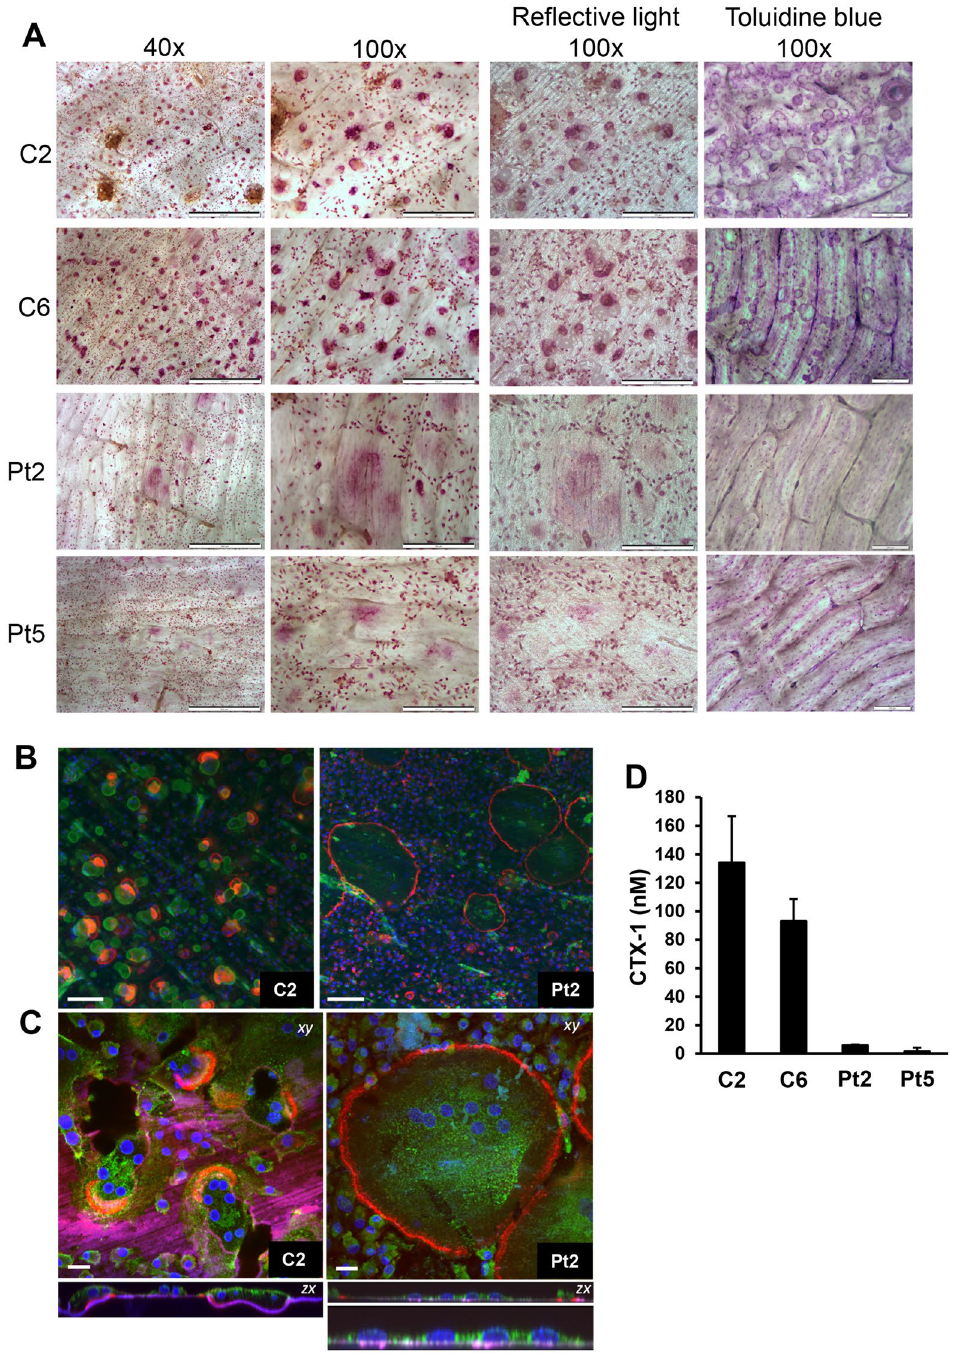
Figure 4. Patient-derived osteoclasts form actin rings but are unable to resorb bone. ( A ) TRAP staining of CD14 + cells cultured in M/RL on bone for eight days. Scale bar 40 × panel: 500 μ m, scale bar 100 × light microscope and reflective light panel: 200 μ m, scale bar 100 × toluidine blue panel: 100 μ m. ( B , C ) Osteoclasts were analyzed by confocal microscopy; ( B ) stained with TRITC-phalloidin (red), DAPI (blue) and the bone surface using a fluorescent bisphosphonate (AF-ALN; green). Resorption pits stain brightly with AF-ALN and can be seen in the control only. Scale bar = 100 μ m; ( C ) stained with TRITC-phalloidin (red), DAPI (blue) AF- ALN (magenta) and the cell membranes with wheat germ agglutinin (green). AF-ALN omitted from upper panel of Pt2 for clarity. Black patches in C2 xy image indicates resorption pits. Bottom panel of Pt2 is a zoom of the zx section illustrating lack of resorption. Scale bar = 20 μ m; ( D ) CTX-1 release in media during day 6 to 8 of culture in M/RL. C1, C6 = controls, Pt2, Pt5 = patients (n =